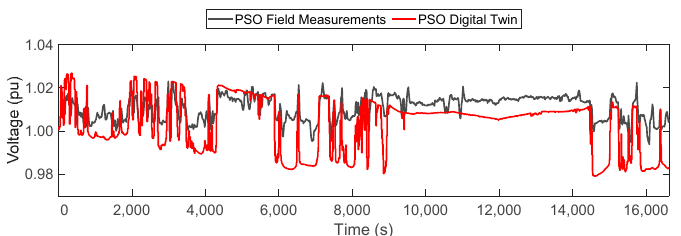
Figure 16. Comparison Between the Digital Twin and the Field Demonstration Voltage at